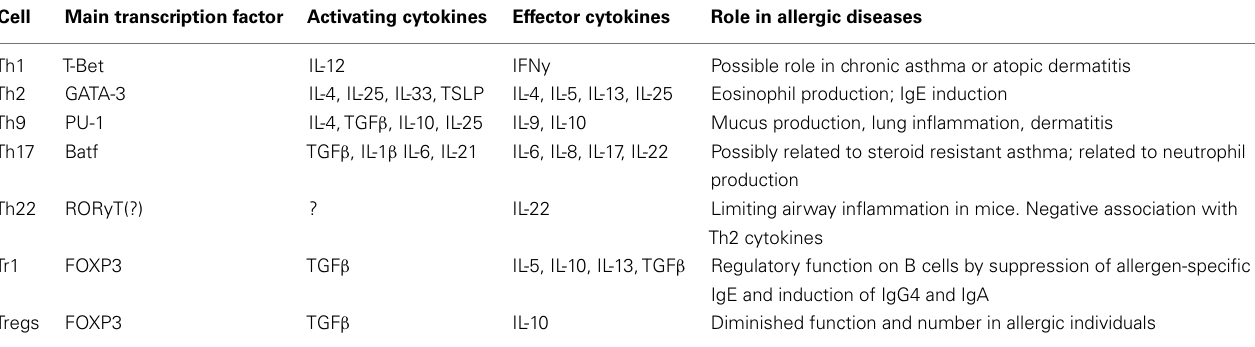
Table 1 | Different subtypes described to play a role in the pathogenesis of allergic diseases.